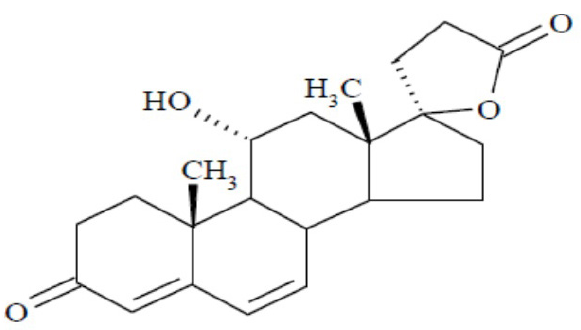
FIGURE 2 - Chemical structure of